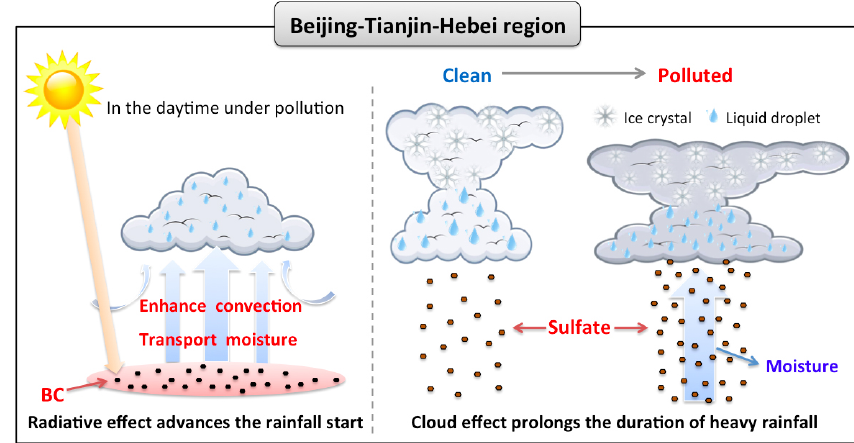
Figure 11. A schematic diagram for aerosol impacts on heavy rainfall over the Beijing–Tianjin–Hebei